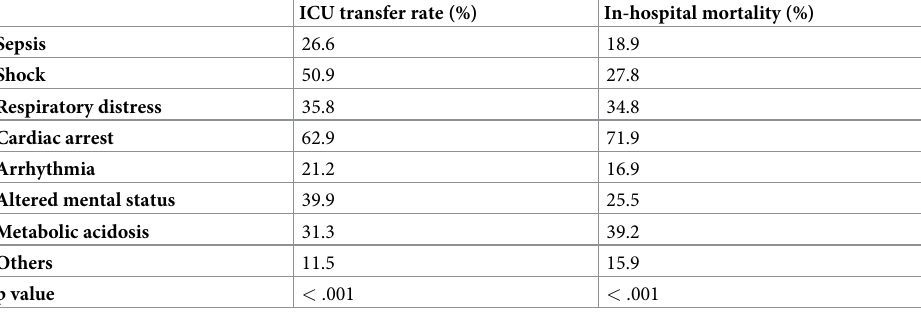
Abbreviations: ICU, intensive care